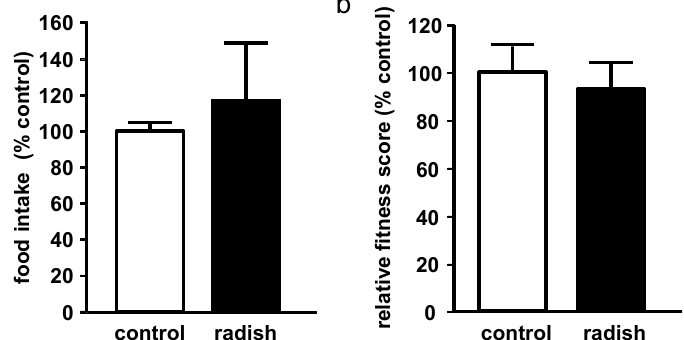
Figure 2. Effect of 10-day radish sprout supplementation on male Drosophila melanogaster . ( a ) relative food intake analyzed by the gustatory assay ( n = 3 + SEM; extraction from 3 × 15 flies); ( b ) relative fitness score detected by the RING assay ( n = 3 + SEM).